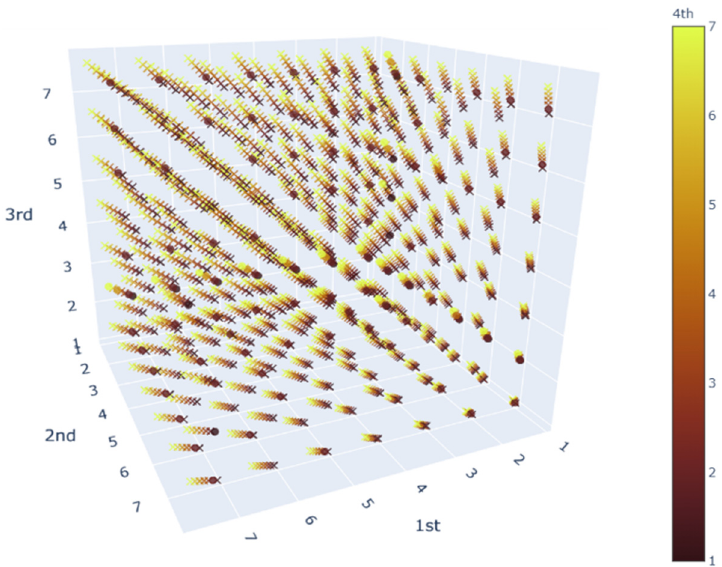
Figure 4. Distribution of English dataset.